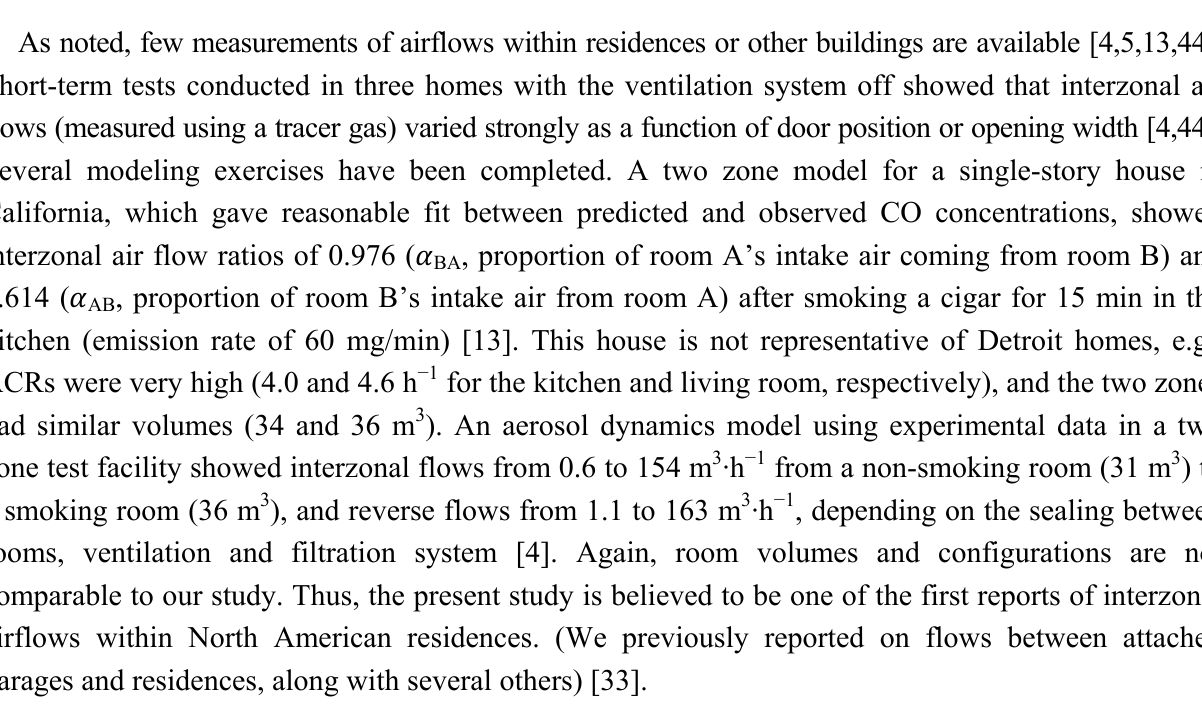
–Q ) and filter (Q ), house and bedroom 1 4 F2 ), including number of out